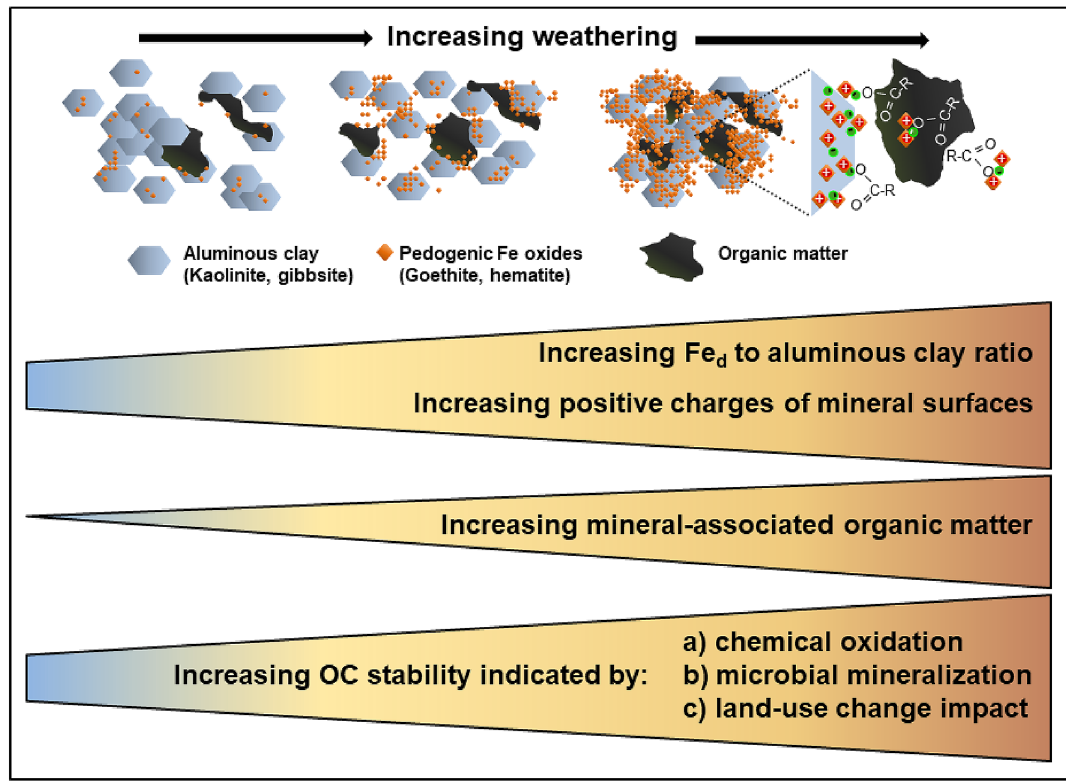
Figure 6. Implications of intensive tropical weathering for the formation of mineral-associated OM and overall OM